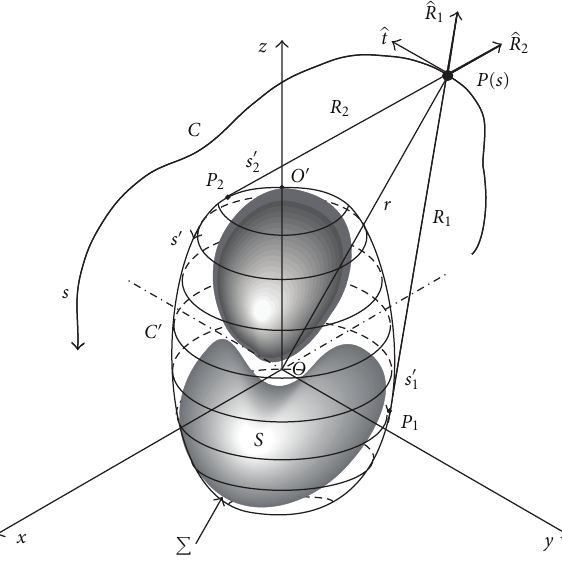
Figure 1: Relevant to a meridian observation